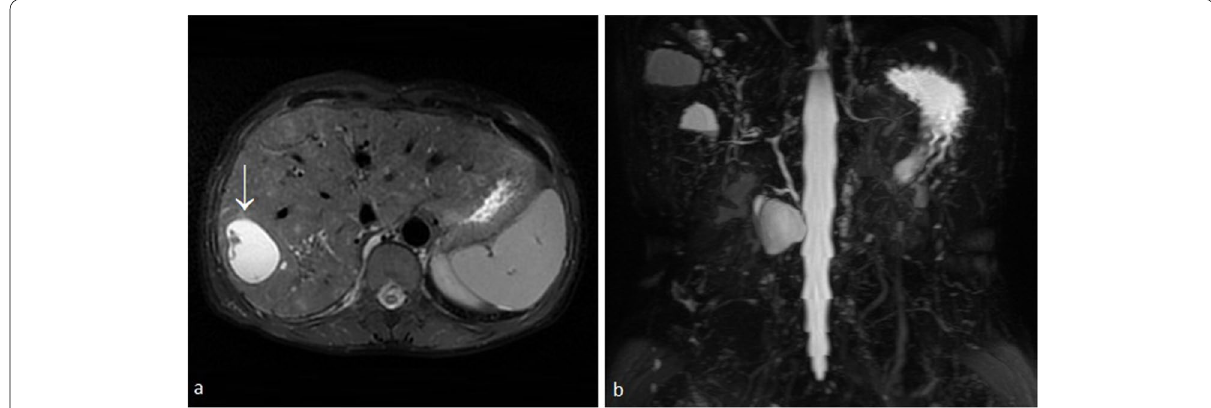
Fig. 5 MRCP image showing a biloma (dot sign) and b alternation of short stenoses with dilatation of the intrahepatic bile ducts in segment VII (ischemic